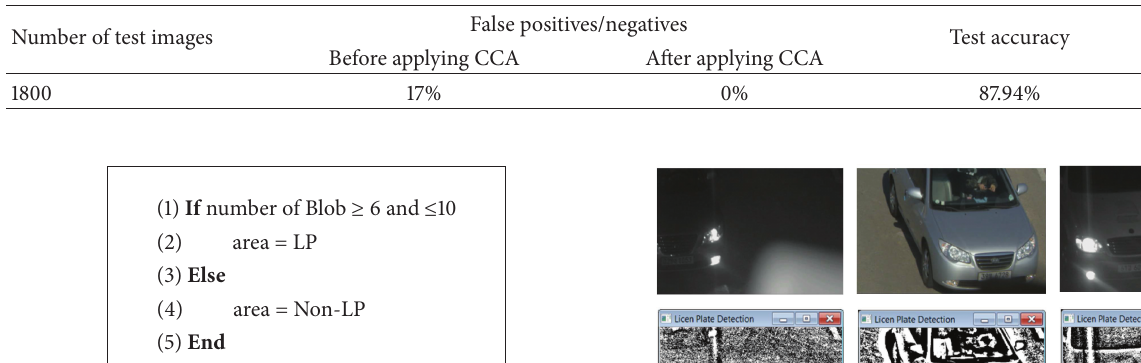
Table 1: LPD using cascade AdaBoost.